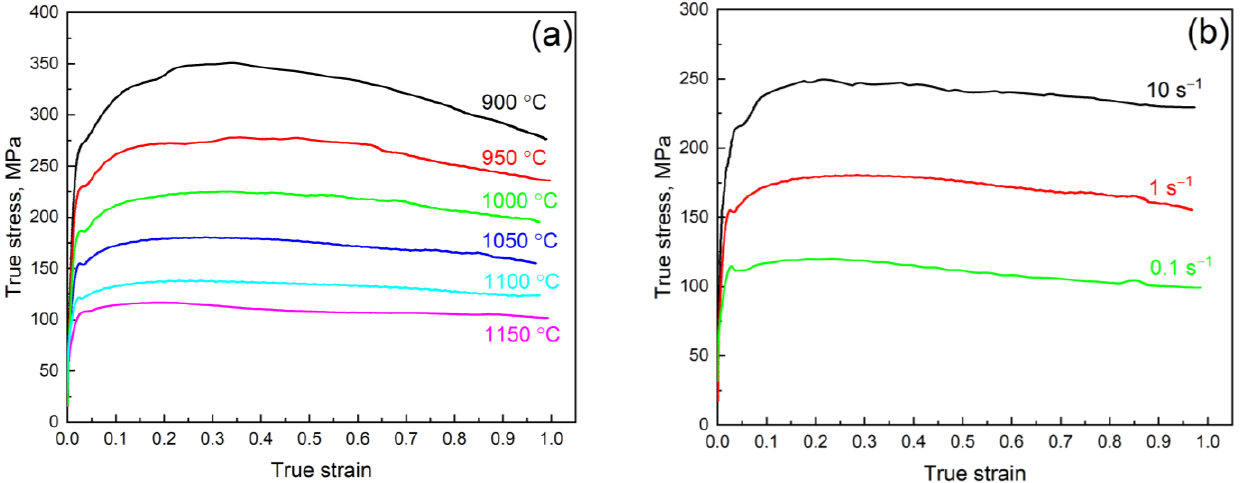
Figure 5. Typical true stress–true strain curves for the Fe–28Mn–8Al–1C steel at a temperature of 1050 °C ( a ) and a deformation rate of 1 s −1 ( b ).